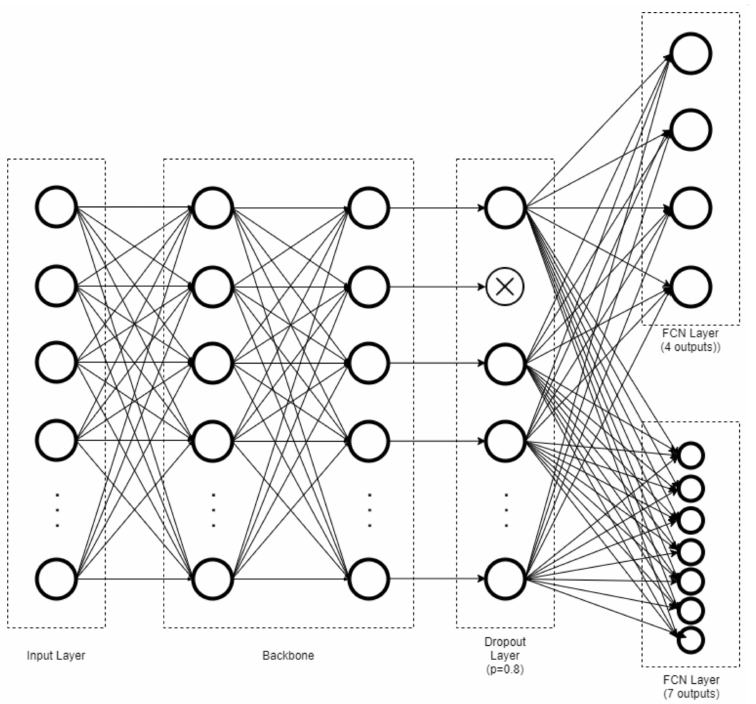
Figure 4. Architecture of model network illustrating fully connected network (FCN) layers toward coarse-grained (4-posture) and fine-grained (7-posture)